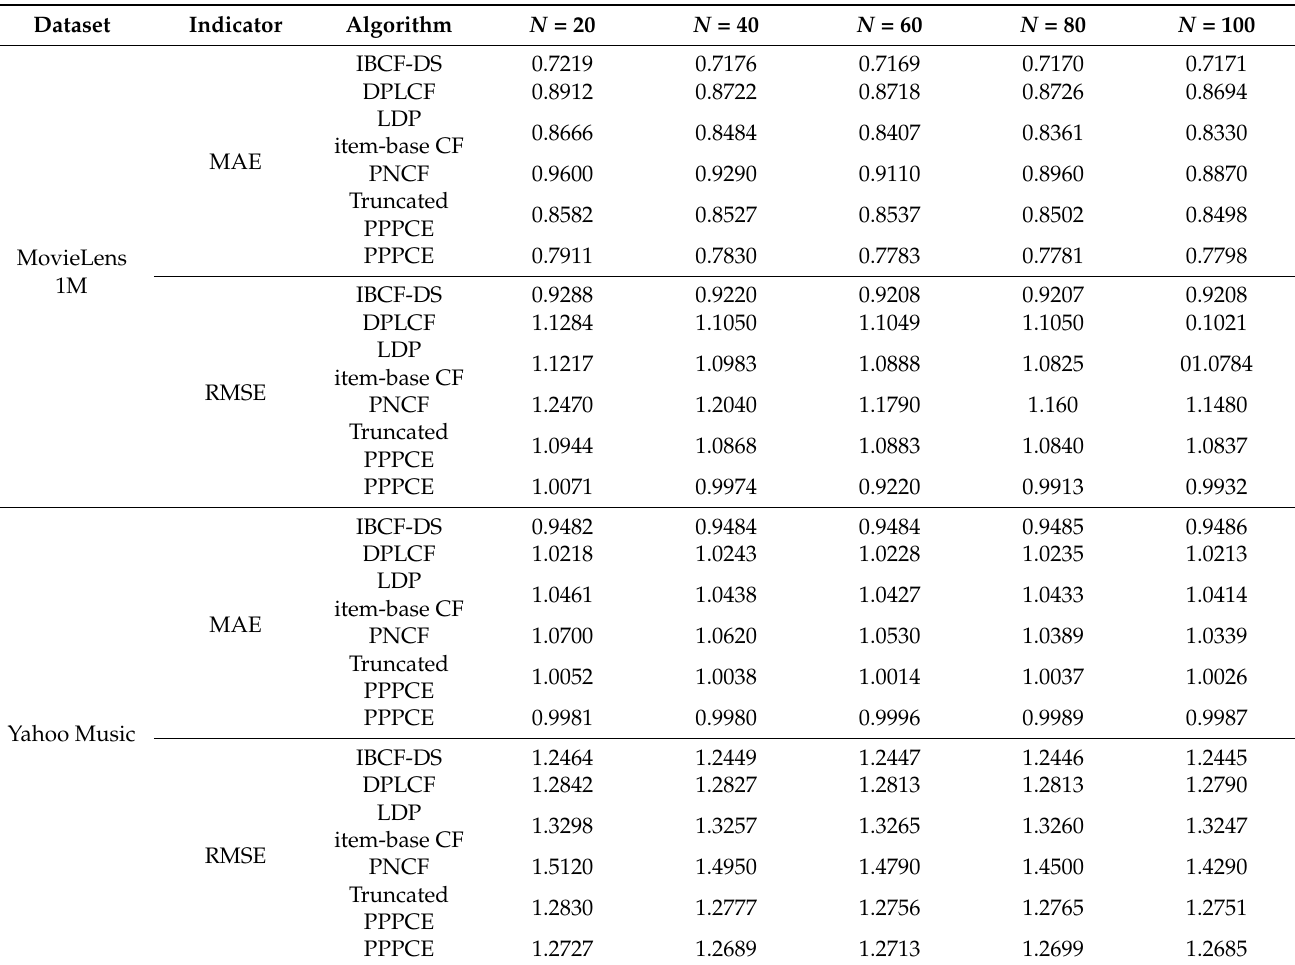
Table 2. Comparison of the algorithm performance with different values of N